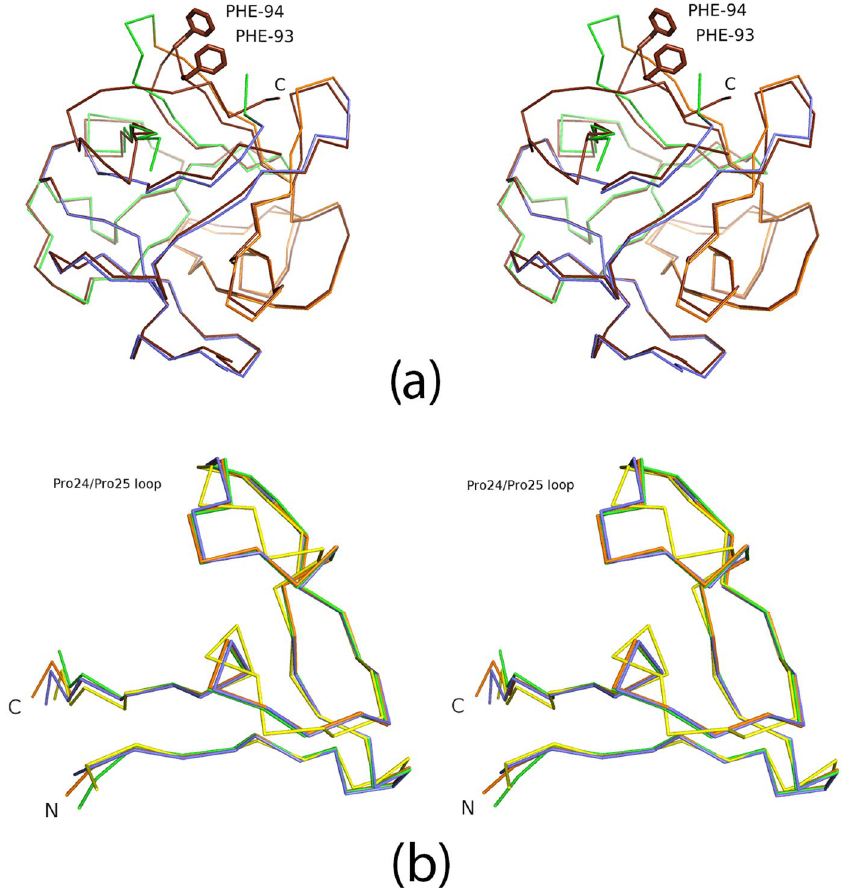
Figure 3. The subdomain structure of Mitsuba-1. ( a ) Stereo view of MytiLec-1 C α trace (chocolate brown) overlaid onto Mitsuba-1 (coloured by subdomain as in Fig. 2). Phe 93 and Phe 94 of MytiLec-1 are shown as sticks, indicating that the surface loop of the protein at this point is truncated relative to other subdomains. ( b ) Stereo overlay of the individual subdomains of Mitsuba-1 and a single subdomain of Threefoil (shown in yellow). Differences between Mitsuba-1 and Threefoil are pronounced at the loop including Pro 24 and Pro 25, or equivalent